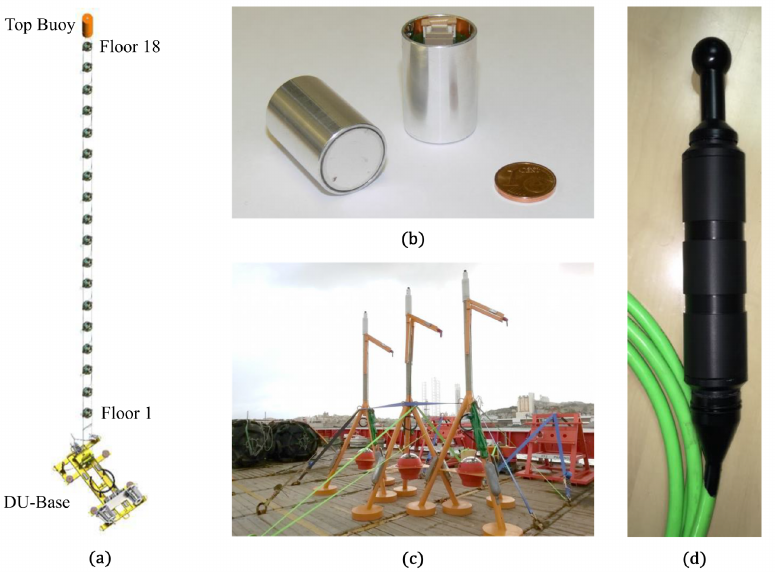
Figure 11. ( a ) Drawing of a KM3NeT DU, composed of an anchored base containing a hydrophone and 18 DOMs (labeled Floor 1, ..., Floor 18), and the top buoy; ( b ) Encapsulated piezoceramic acoustic sensor and electronic board with a pre-amplifier; ( c ) Three autonomous acoustic beacons before being deployed in ARCA; ( d ) Hydrophones used in KM3NeT (from Ref.